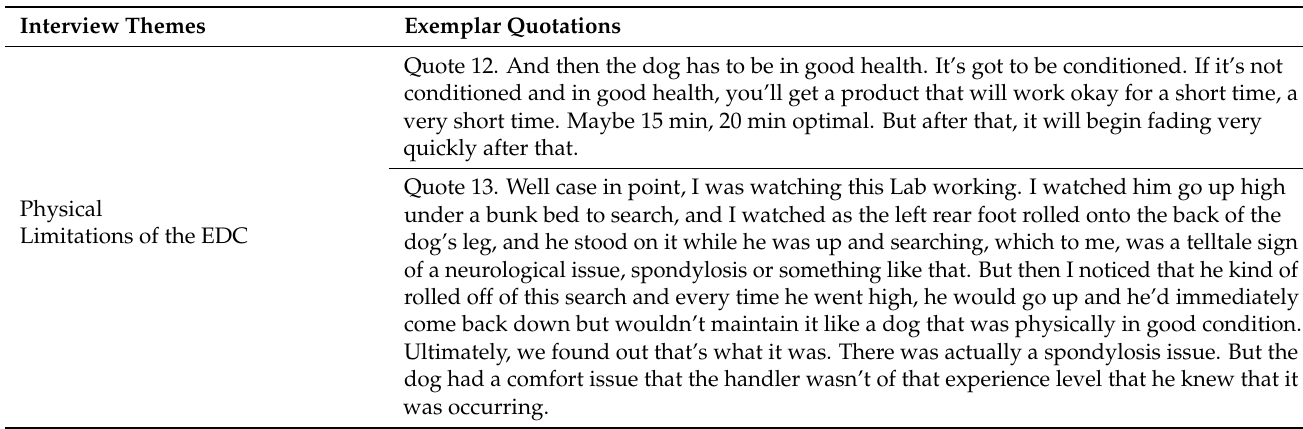
Table 3. EDC team factors—physical limitations of the EDC themes and exemplar